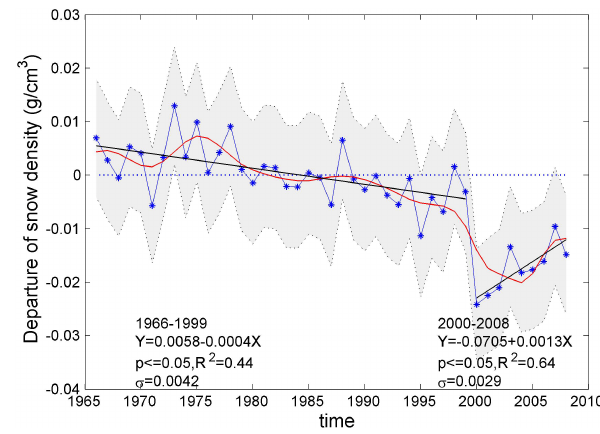
Fig. 7. Variation of annual mean snow density across the former USSR from 1966 through 2008, with respect to the 1971–2000 mean. The thin solid line with asterisk is the computed annual mean of snow density; the solid curve represents the trend of wavelet anal- ysis; the gray area represents one standard deviation from the 1971– 2000 mean for each year; the thick solid line of change trends in snow density with time, where y represents snow density in gcm − 3 and x represents time in snow cover years, 1966 was the first snow cover year, therefore, x ranged from year 1 (1966) to year 43 (2008) in the simulation of annual mean snow density. p is the confidence level for the coefficient estimates, R 2 is the goodness of fit coeffi- cient, and σ is one standard